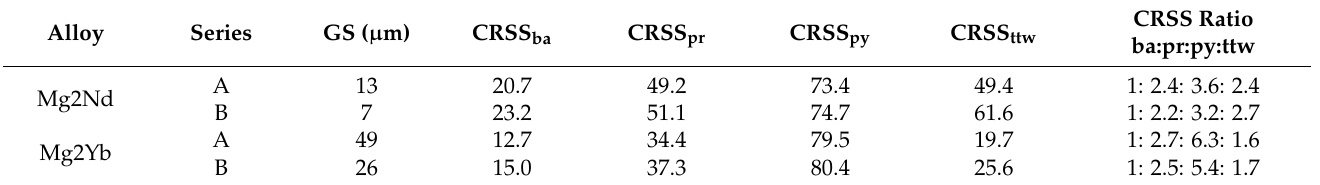
Table 5. Initial critical resolved shear stresses (CRSS) for the different slip and twinning